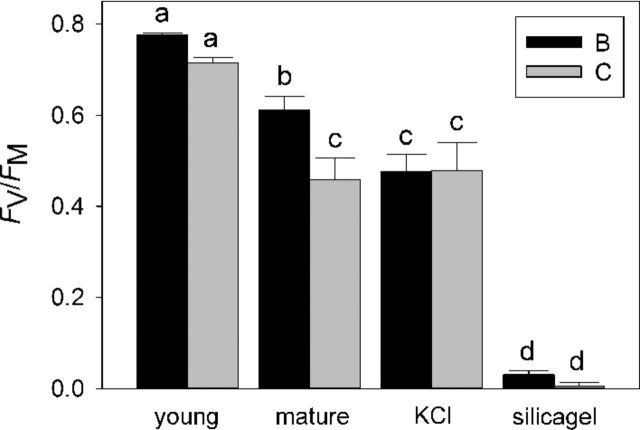
Maximum quantum yield of photosystem II (FV/FM) of young and mature cultures of Zygnema sp. strains B and C prior to desiccation, and of mature cultures that were rehydrated after desiccation above KCl (86% RH) or silicagel (18% RH); mean +SD, n = 5. Different letters represent statistical differences between means (P < 0.01; general linear model factorial ANOVA, Tukey's post hoc tests).